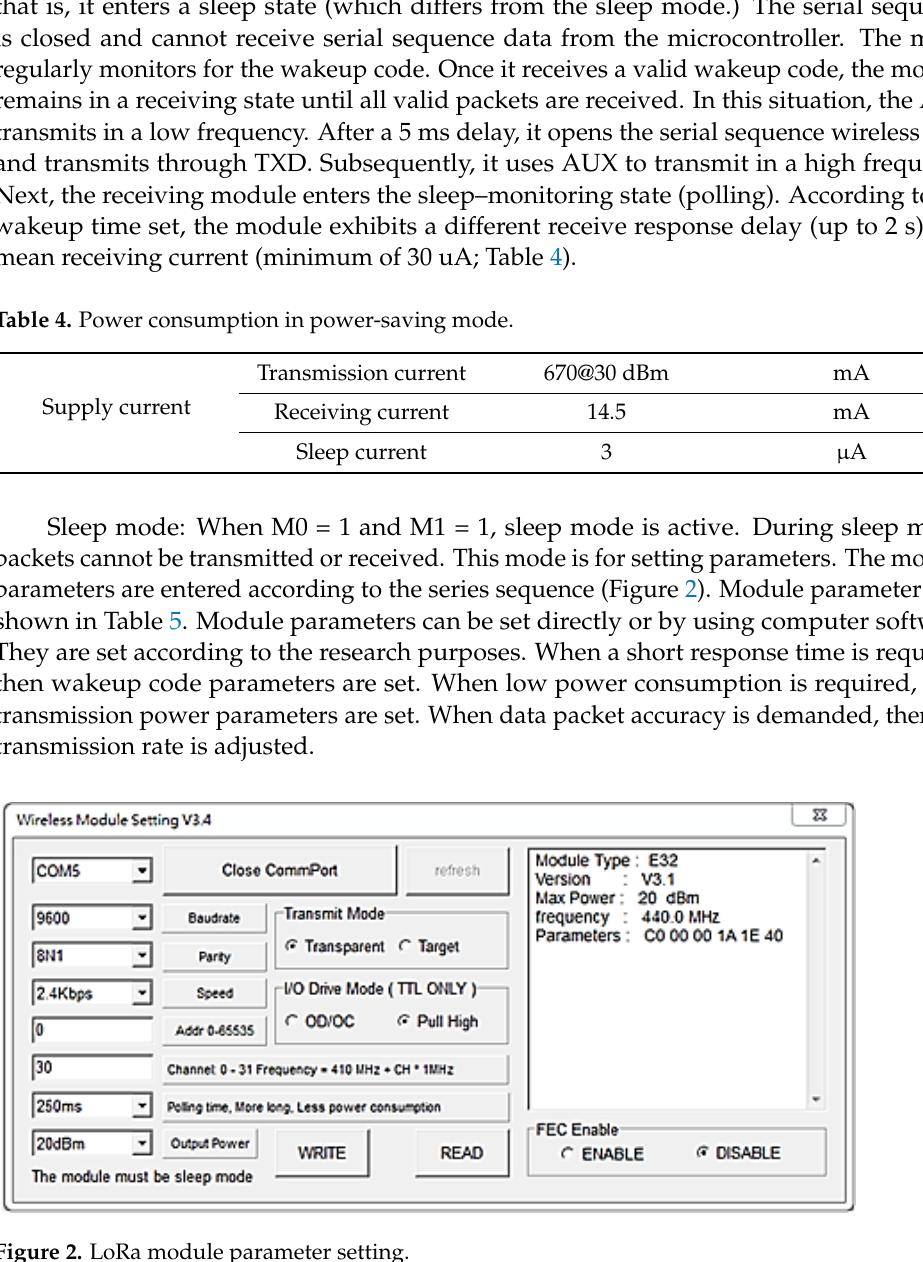
Figure 2. LoRa module parameter setting.